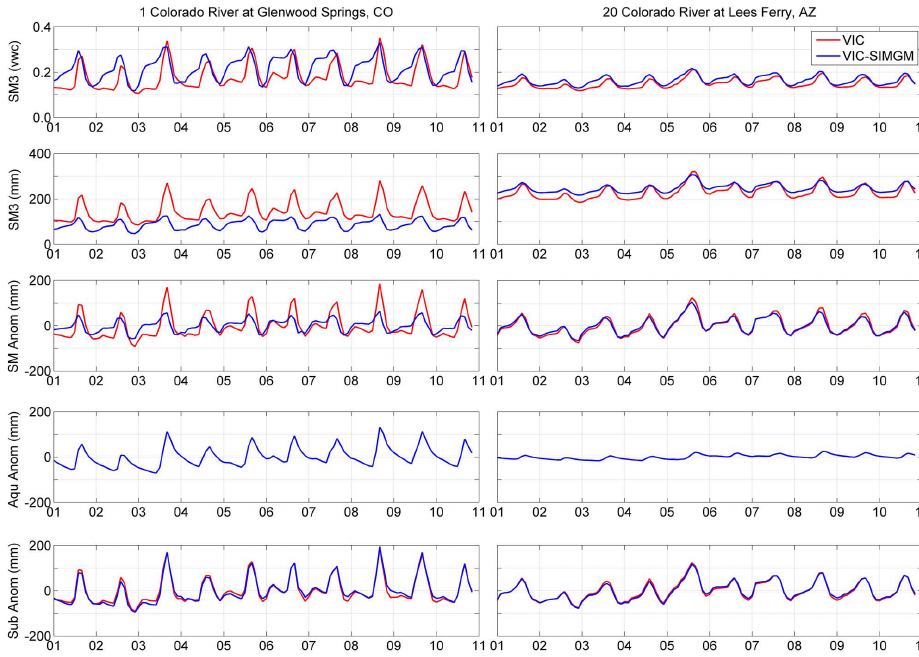
Fig. 5. Time series of the subsurface storage terms (from top to bottom): third layer soil moisture by volumetric water content, third layer